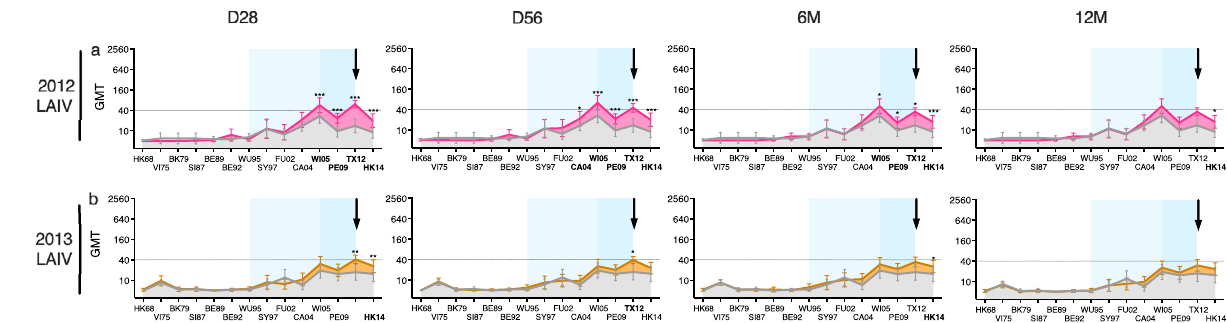
Fig. 5 The A/H3N2-speci fi c hemagglutination inhibition (HI) antibody landscapes after vaccination with live-attenuated in fl uenza vaccines (LAIV) in children. Antibody landscapes were generated using the groups ’ geometric mean HI titre (GMT) against 14 antigenically distinct in fl uenza A/H3N2 viruses (see Table 1 for the strains used). Error bars represent the 95% con fi dence intervals of the GMTs. The pre- vaccination GMTs at day (D)0 are displayed in grey. Antibody landscapes of children vaccinated with LAIV in 2012 (2012 LAIV, n = 20) (pink) ( a ) or in 2013 (2013 LAIV, n = 22) (brown) ( b ) at D28, D56, 6 months (M) and 12 M post-LAIV are shown. Individual landscapes can be found in Supplementary Figure 3. The black arrow indicates the vaccination virus, and the dotted line indicates the HI titre of 40. The viral exposure period is shown in blue based on the group ’ s median age, and light blue indicating the oldest individual in the group. Pre- and post-LAIV titres were compared using non-parametric repeated measure Friedman test with Dunn ’ s multiple comparison correction for each vaccination group. * P < 0.05, ** P < 0.01, *** P = <